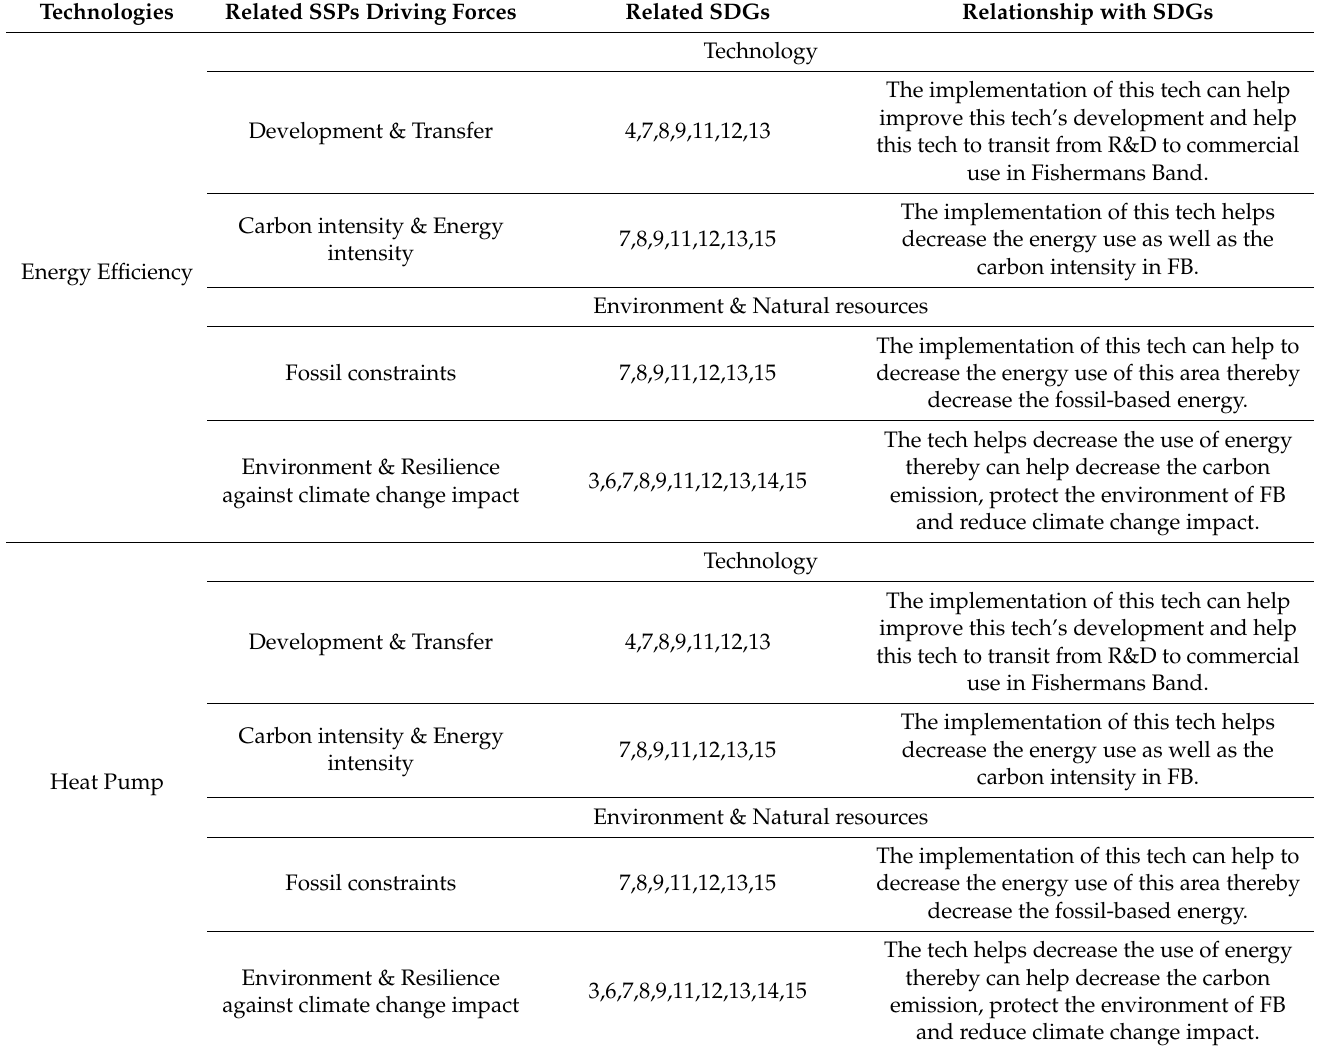
Table A3. The elaboration of how the technologies and the SDGs were mapped via